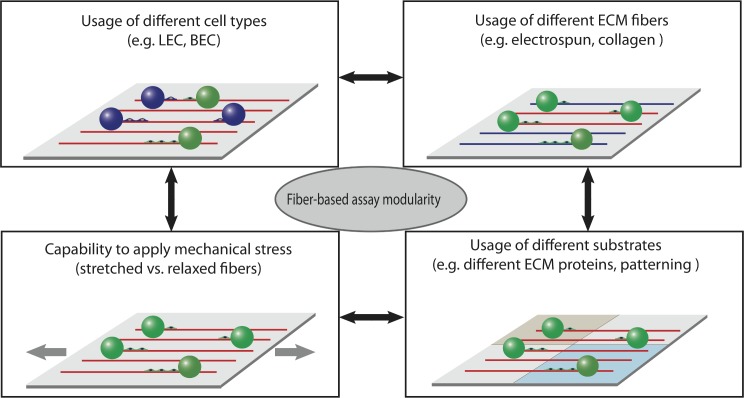
The modularity of the fiber-based assay allows versatile experimental setups.Schematic showing how the three major components of the fiber-guided assay can be modified to address a multitude of questions in the field of (lymph)angiogenesis and beyond: the beads can be cultured with different cell types, different fibers can be used, and the chemistry and/or topography of the underlying substrate can be modified. In addition, the capability to apply mechanical stress allows investigating the role of biomechanical forces in all questions asked.